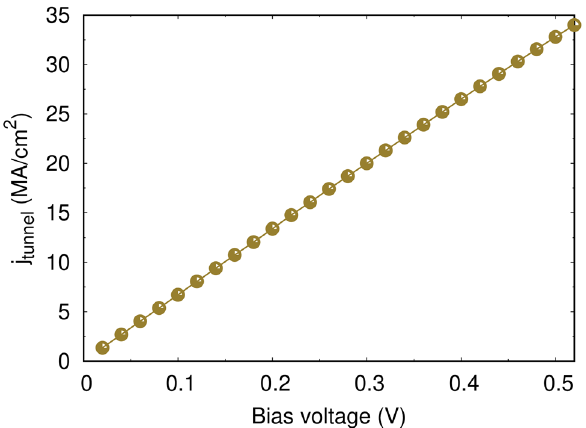
Figure 2. The average tunneling current density flowing through the MgO barrier of 0.85 nm thickness as a function of bias voltage calculated from the modified Simmons equation: The line of best fit is j tunnel V MA/cm 2